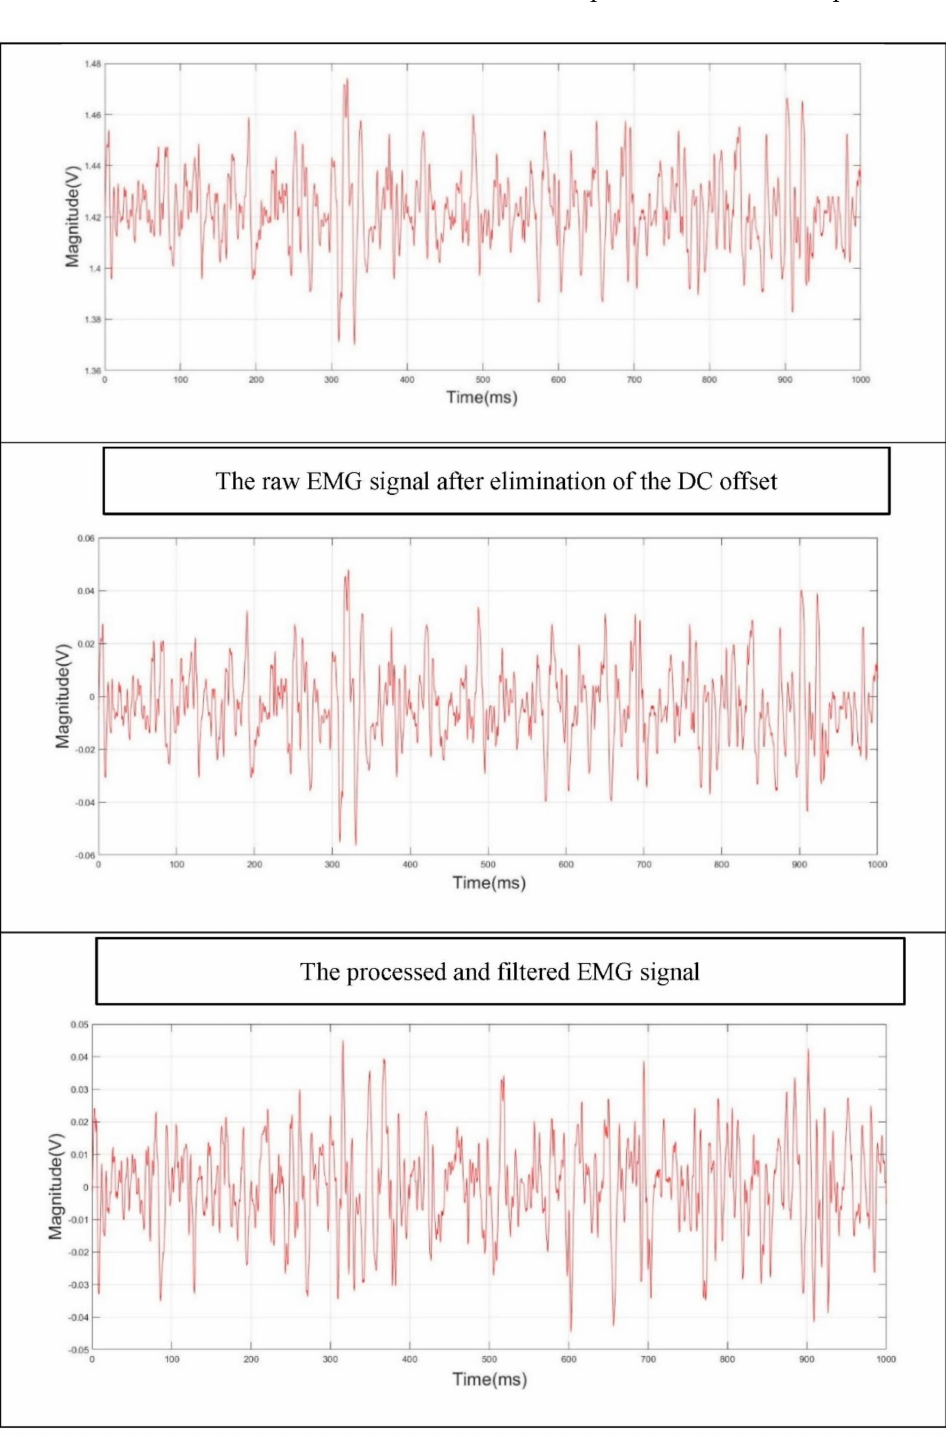
Figure 3. Steps for the processing and filtering of the raw EMG